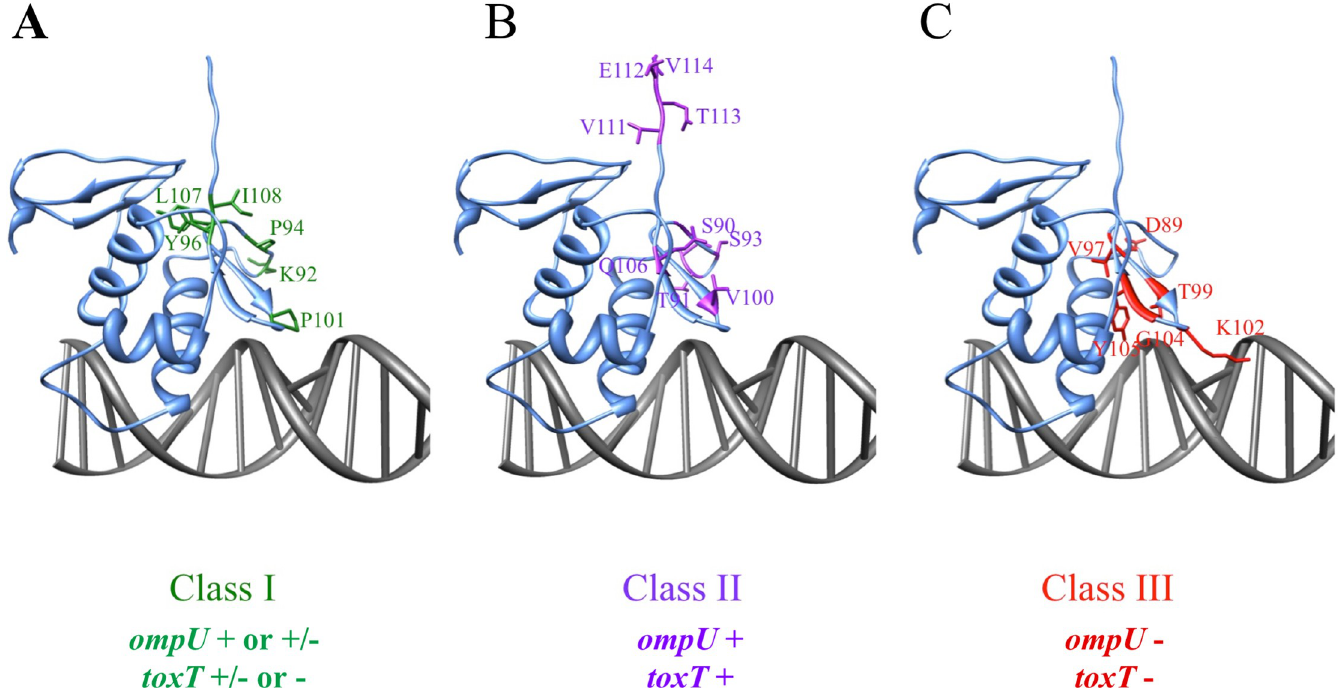
Fig 3. Assignment of three classes of ToxR wing mutants. ToxR w-HTH domain was previously modeled using I-TASSER (http://zhanglab.ccmb.med.umich.edu/ I-TASSER/)[26]. This previously-generated model with then modeled onto DNA using Chimera and the NMR structure of the ToxR homolog PhoB bound to DNA {Yamane, 2008 #5306}. Mutants were divided into classes based on phenotype. A) Class I mutants (green) are greater than 2-fold defective for toxT activation relative to ompU activation when expressed from a plasmid (Fig 2). B) Class II mutants (purple) are not significantly defective for activation of either promoter. C) Class III mutants (red) are required for activation of both toxT and ompU promoters and DNA binding.